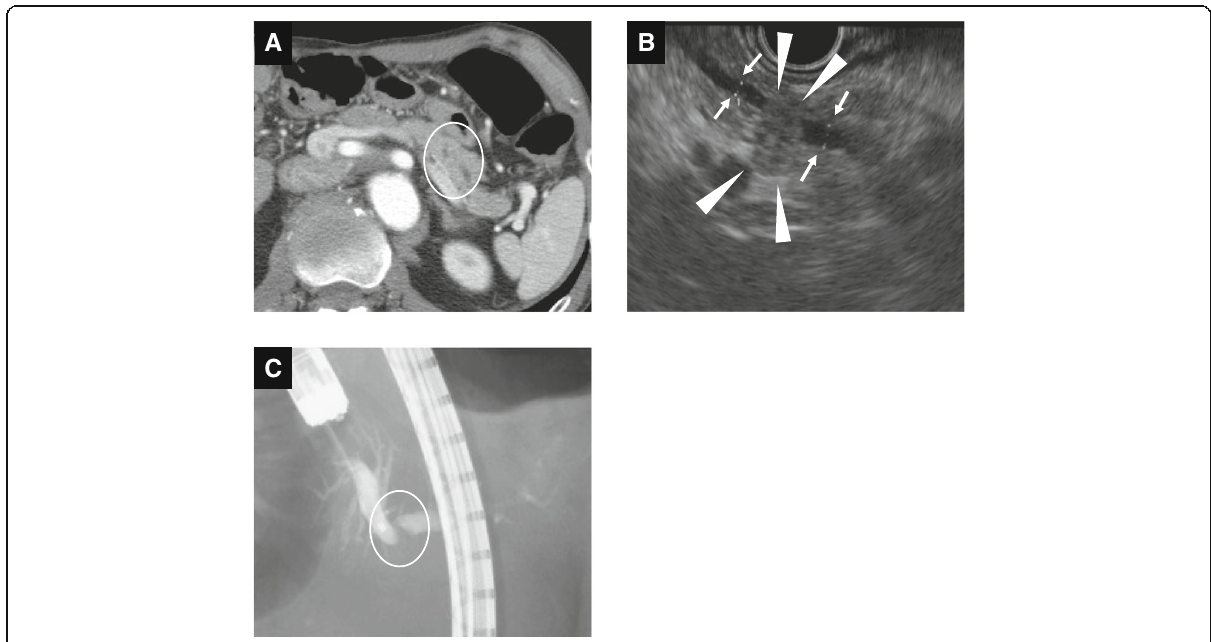
Fig. 3 Preoperative imaging findings during the assessment of the resected remnant pancreas lesion 16 years after the initial operation. a Enhanced computed tomography showed a low-density mass at the remnant pancreatic body (circle). b Endoscopic ultrasonography showed an isoechoic and hypovascular mass (7 mm in diameter) protruding into the main pancreatic duct (MPD) of the pancreas body (arrowhead). A slight change in the diameter of the MPD between the proximal side and the distal side of the mass was observed (arrow). The MPD wall adjacent to the mass was ill-defined. c Endoscopic retrograde pancreatography showed a localized narrow segment with irregular tapering (4 mm in length) in the MPD of the remnant pancreatic body